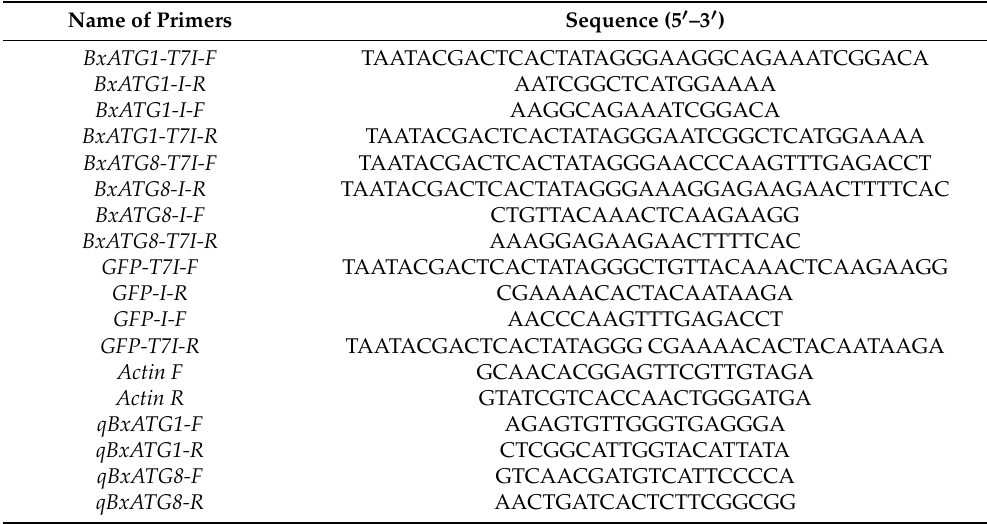
Table 2. PCR primers used in the